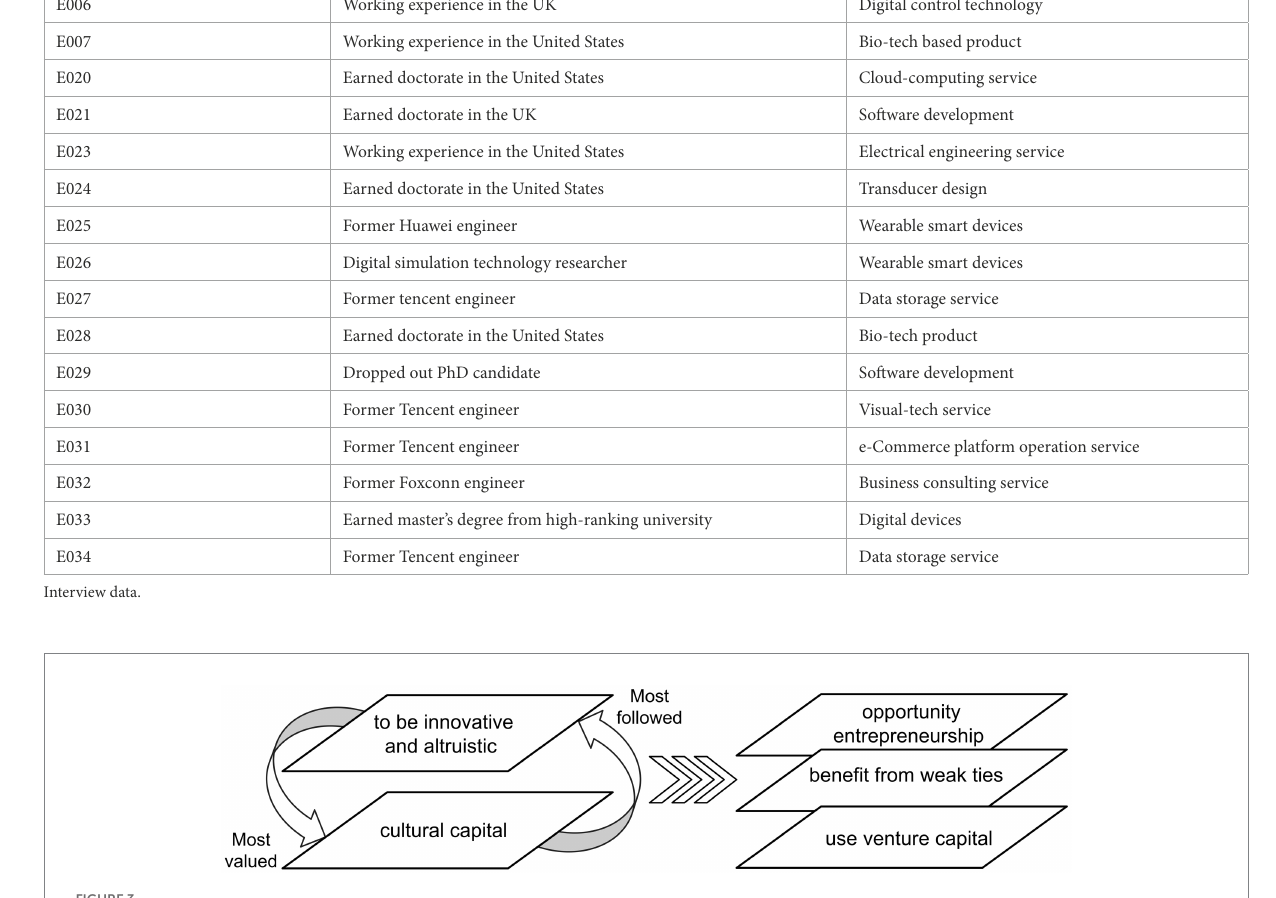
FIGURE 3 Entrepreneurship practice patterns (autonomous phase: 2009–2018).